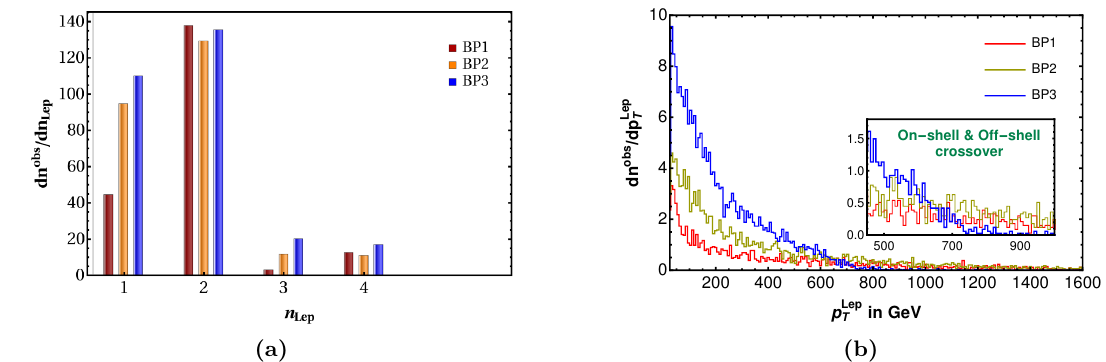
Figure 3. The lepton ( e ± , µ ± ) multiplicity distributions, n Lep (a), and the lepton p T distributions, for the first lepton only (b), for the benchmark points at the centre of mass energy of 14 TeV p Lep T with the integrated luminosity of 3 ab − 1 .